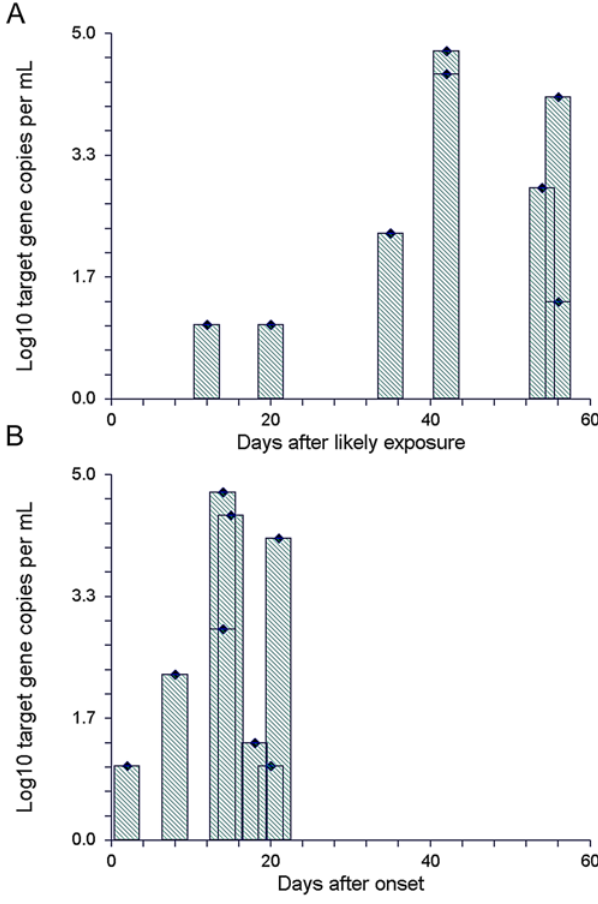
Figure 2. Cell-free Schistosoma DNA concentrations in plasma of patients with acute disease (Katayama syndrome) plotted against the days post exposure or post onset of symptoms when the tested samples were taken. 10 mL of plasma were tested for cell-free DNA.